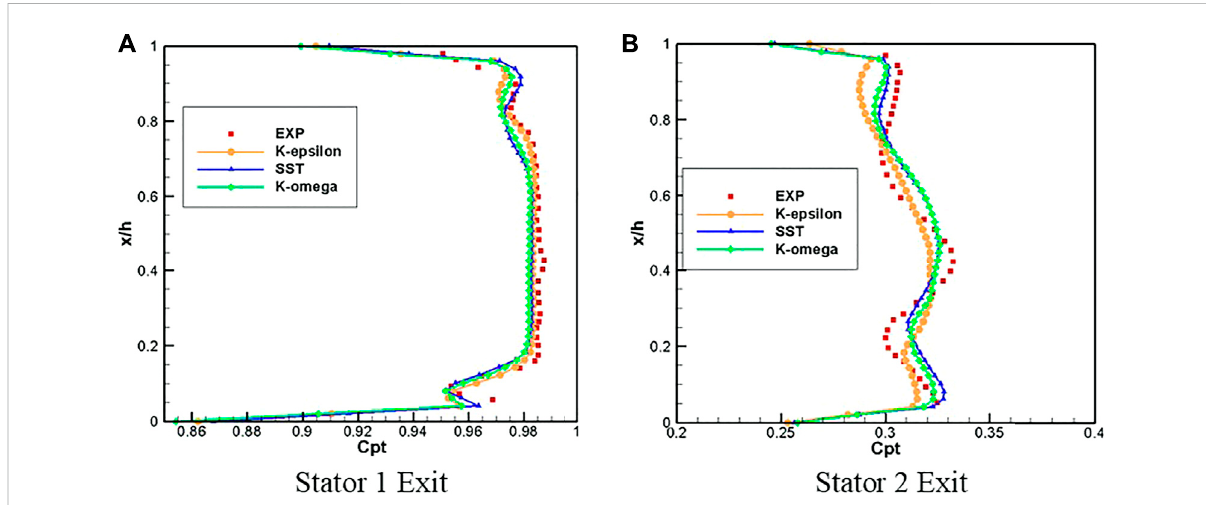
FIGURE 4 Comparison of numerical results with experimental data on the total pressure loss coef fi cient at the outlet (Behr T.,1995). (A) Stator 1 Exit. (B) Stator 2 Exit.